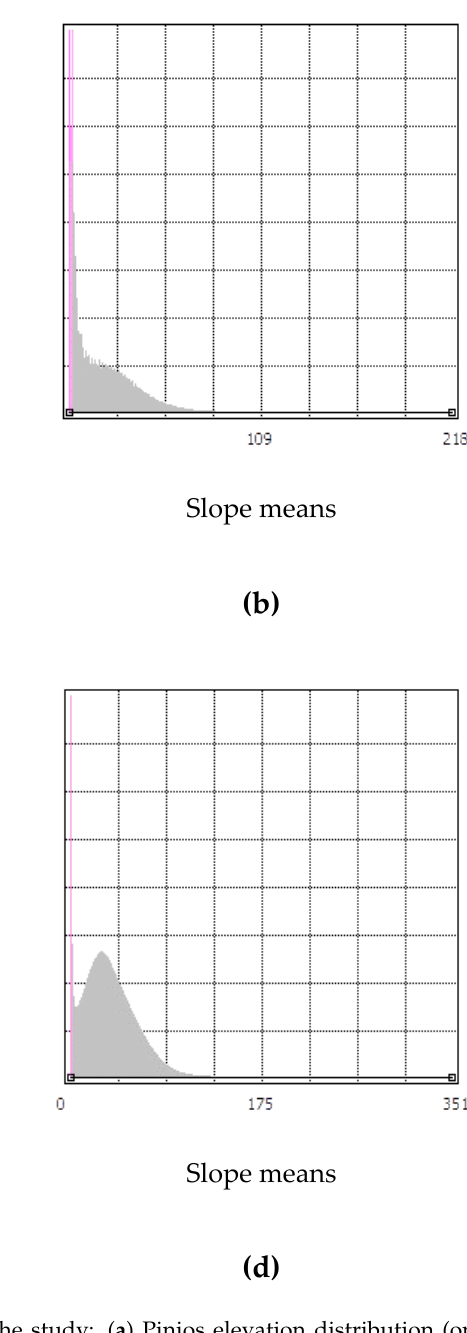
Figure 9. The topographic data distributions of the study: ( a ) Pinios elevation distribution (one small extra peak); ( b ) Pinios slope distribution; ( c ) Acheloos elevation distribution (two extra peaks); ( d ) Acheloos slope distribution (skewed normal distribution).